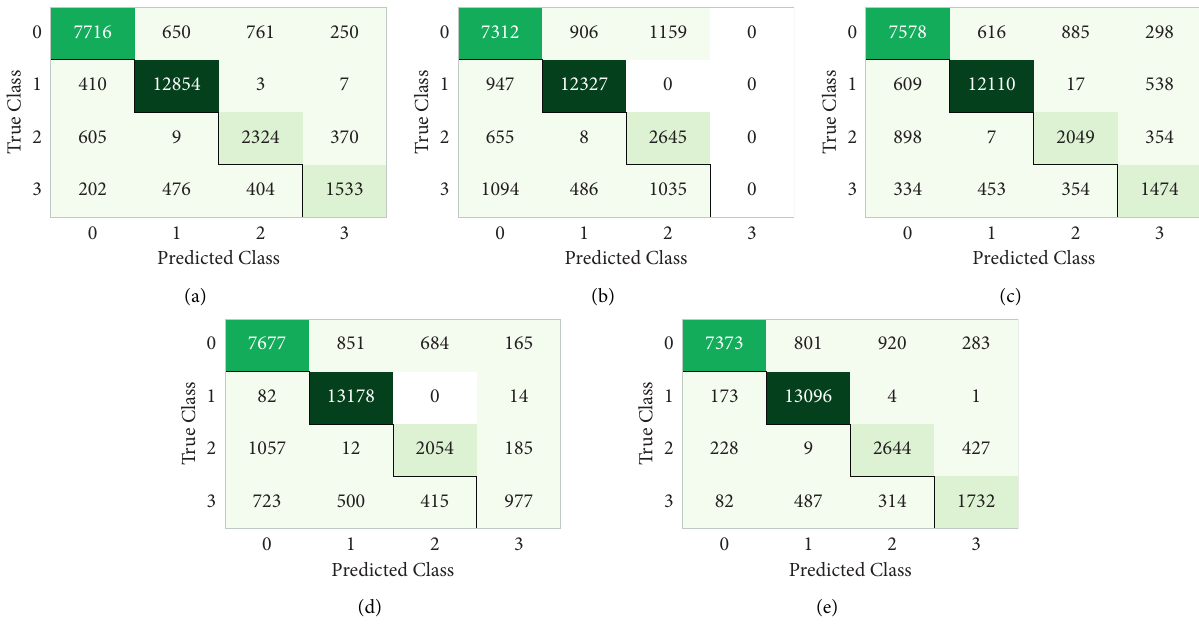
Figure 5: Confusion matrix for different models. (a) KNN. (b) NB. (c) SVM. (d) RF. (e)